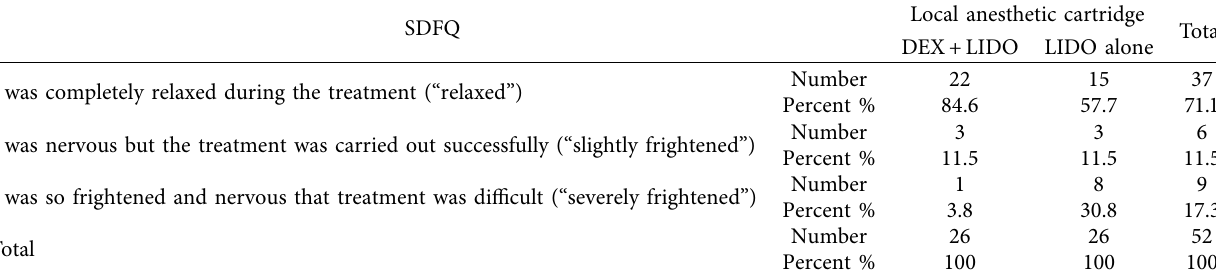
Table 3: Patients’ reports on sedation using